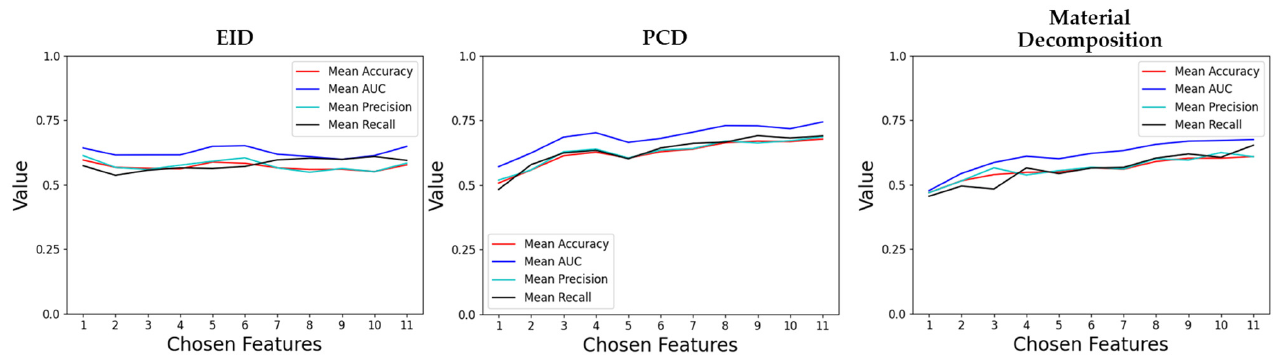
Figure 6. Plots of various performance metrics as functions of the number of features chosen for classifier training. One plot is shown for each of the RF types (EID, PCD, material decomposition). These plots represent the results of an exhaustive search analyzing how classification performance varies when choosing different numbers of features ranging from 1 to 11.